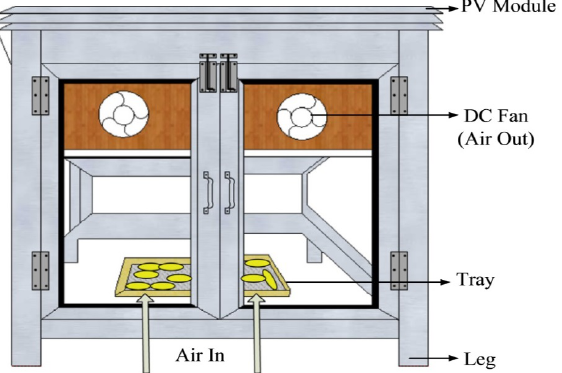
Figure 10. Schematic diagram of PV/T integrated greenhouse dryer